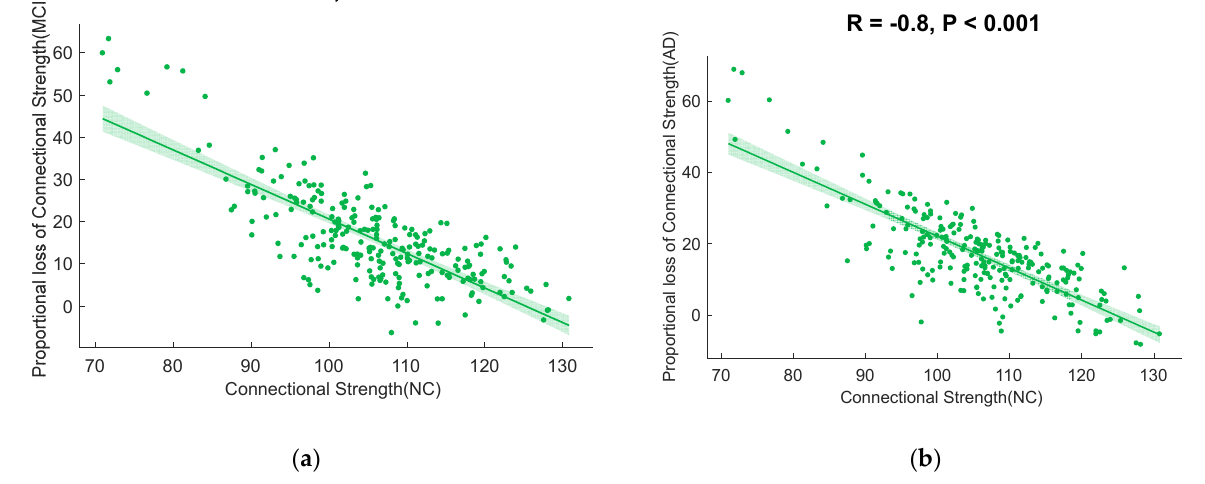
Figure 3. Scatterplots illustrating the relationship between the connectional strength in normal controls and PLFCS in disease groups. ( a ) The correlation between the connectional strength in normal controls and the PLFCS in MCI subjects. ( b ) The correlation between the connectional strength in normal controls and PLFCS in AD subjects.